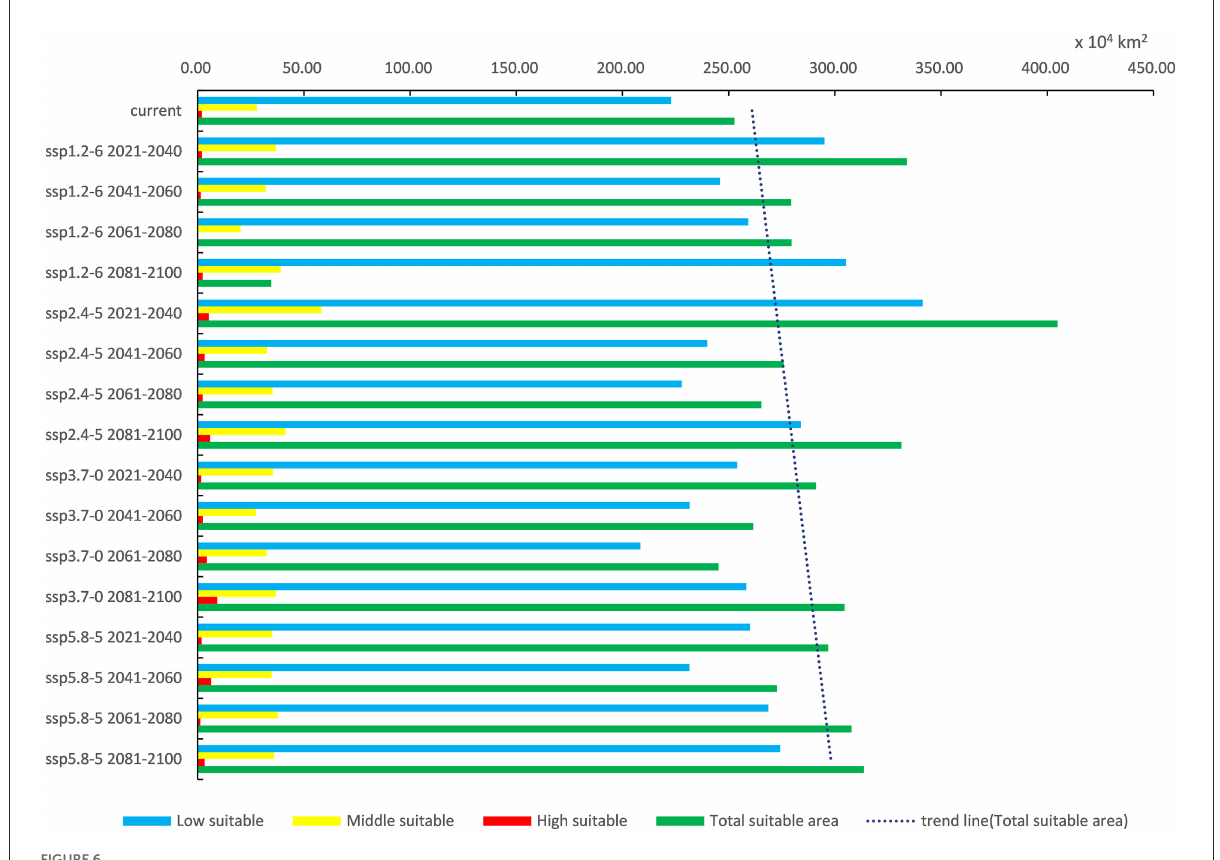
FIGURE6 Variation trend of suitable areas for P. hesperomys in China under current and future climate scenarios.